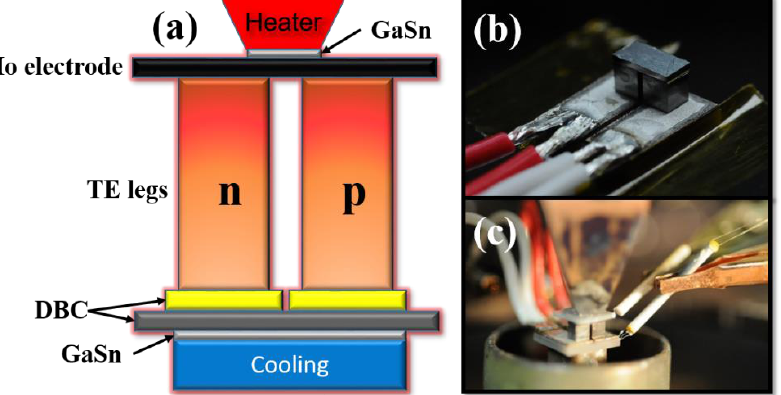
Figure 5. ( a ) The structure of skutterudites (SKD) uni-couple module, ( b ) the picture of SKD uni-couple module and ( c ) the SKD uni-couple module installed in the measurement system. The Direct Bond Copper (DBC) part includes Cu electrode (yellow parts) and AlN substrate (dark gray part). The temperature-dependent module resistance, open-circuit voltage, output power, and conversion efficiency were measured under hot-side temperature up to 679 K, as shown in Figure 6.